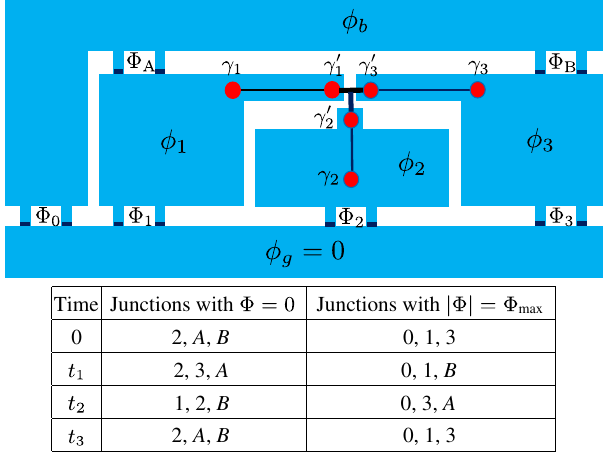
FIG. 12. Top panel: Modified T -junction structure designed to allow for parity measurements at each turning point. Bottom table: Flux values for measurement at the turning points. Note that a junction with Φ ¼ 0 maximizes the Josephson energy and phase locks its neighboring superconductors, while a junction with j Φ j ¼ Φ minimizes its Josephson energy and essentially max decouples the neighboring superconductors. At time t 1 , islands 2 and 3 are phase locked to the ground and decoupled from the bus, while island 1 is phase locked to the bus and decoupled from the